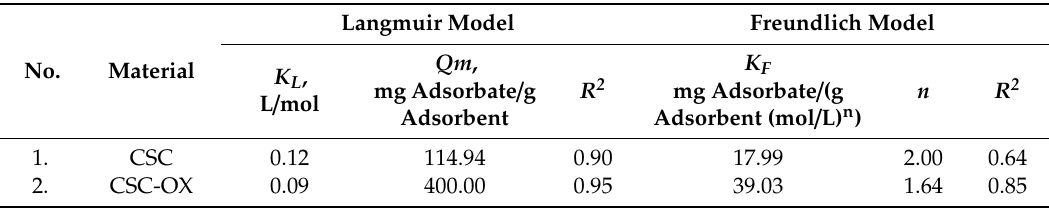
Table 2. Constant value of various fitting model of metronidazole